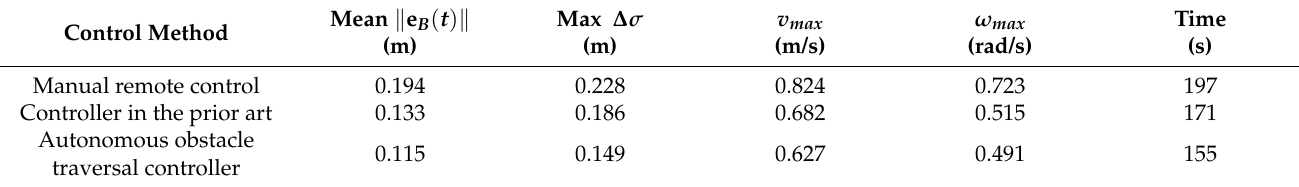
Table 3. The performance comparison results of the three controllers that traversed the circular experimental